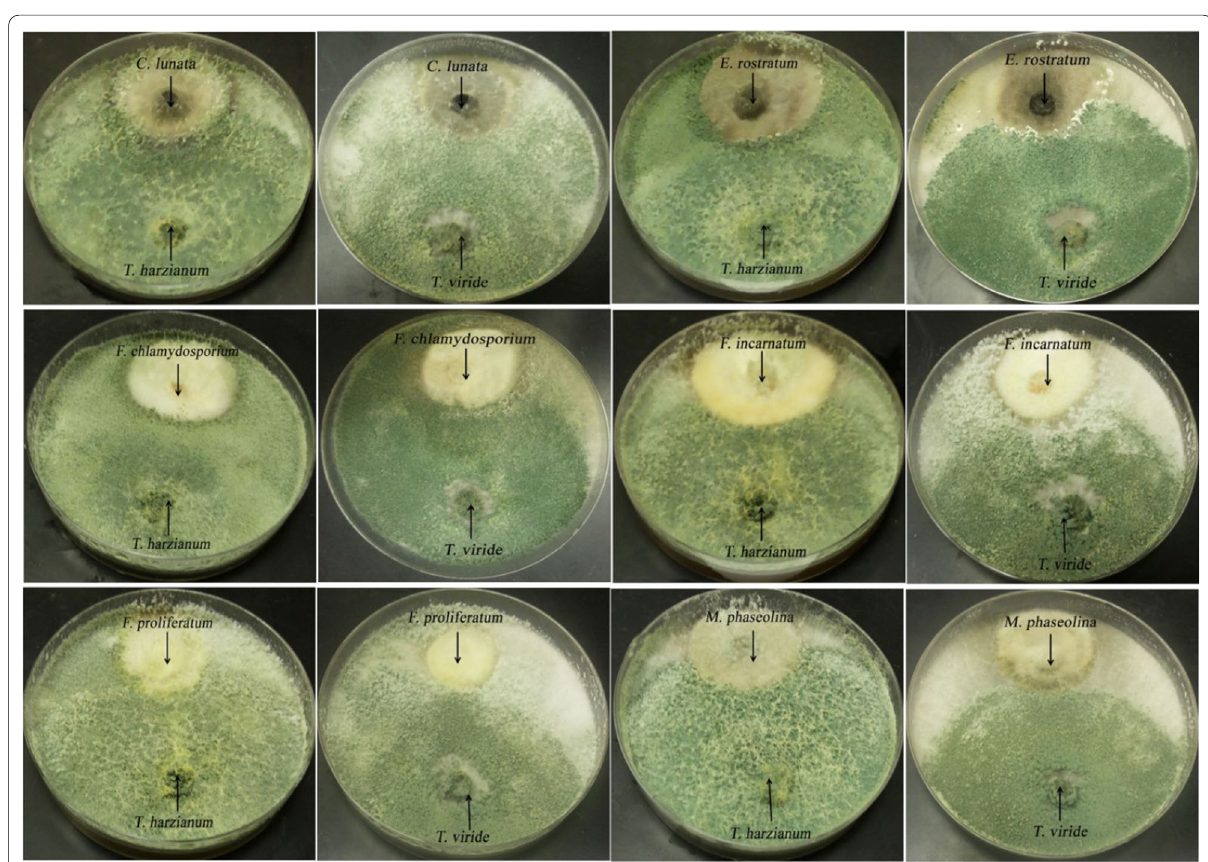
Fig. 1 Dual culture assay of T. viride and T. harzianum against fungal phytopathogens of